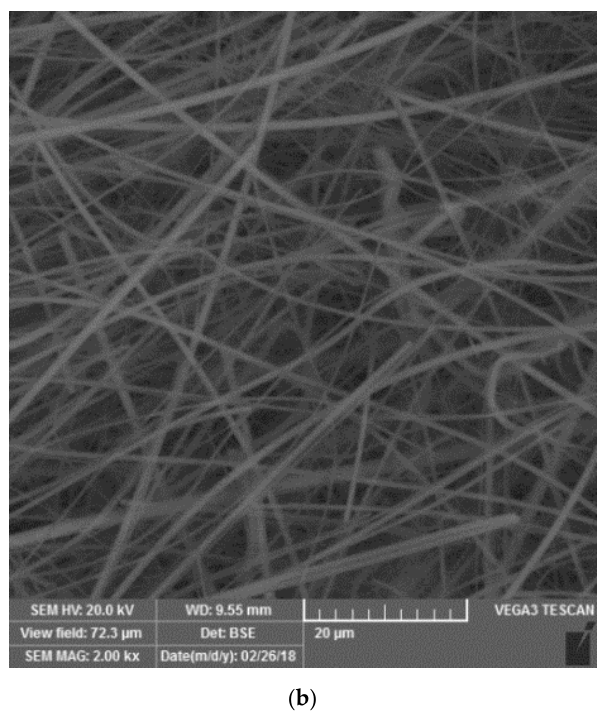
Figure 4. The SEM images with ( a ) the structure of the cellulose paper (resolution 200×) and ( b ) glass fibre paper (resolution 2000×).